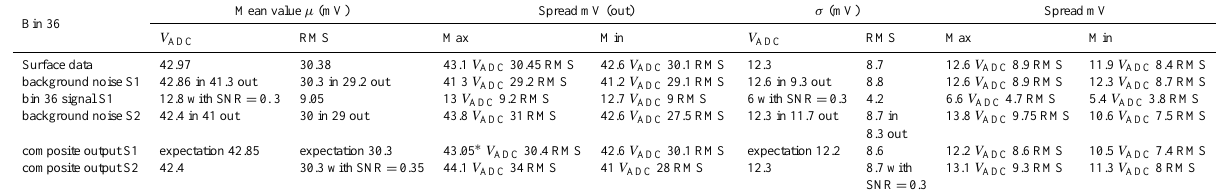
Table 2. Comparison between the surface data and the retrieved characteristics derived from both numerical simulations.